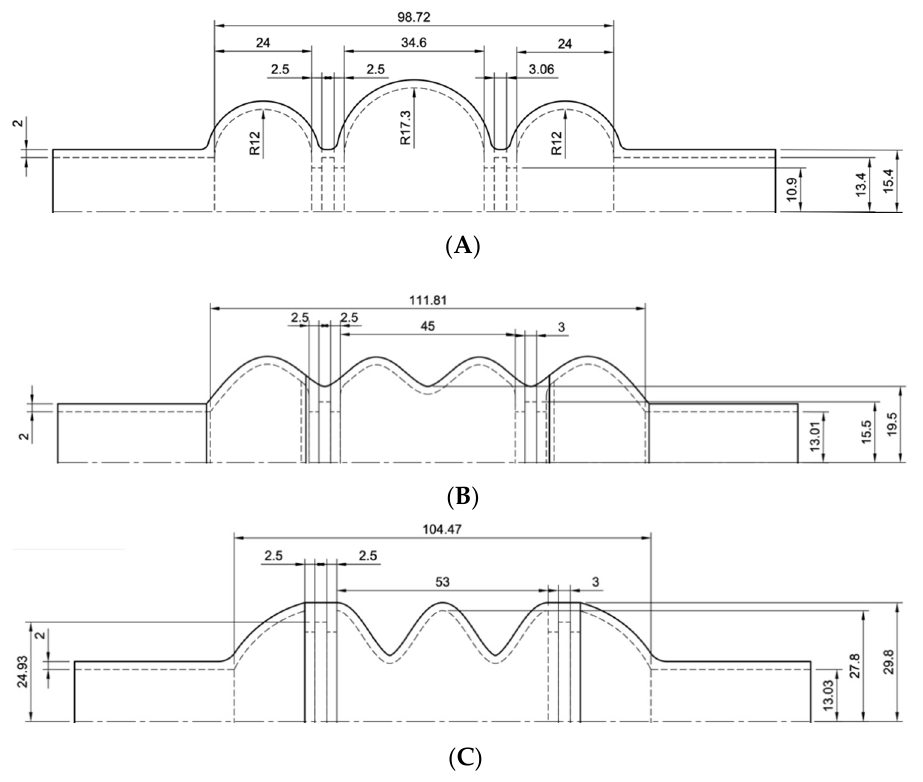
Figure 3. Drawings of the three ventricular chambers. Sketches ( A – C ) provide the dimensions of the chambers.